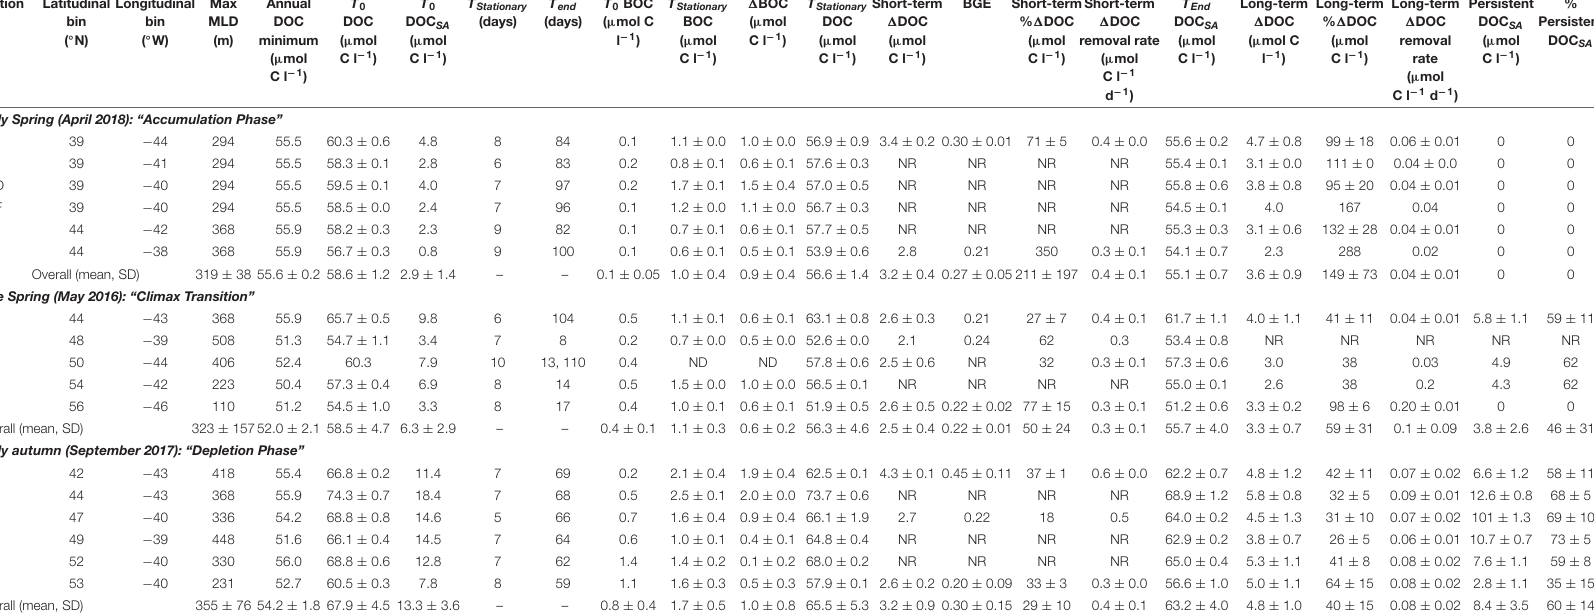
TABLE 1 | BGEs and DOC bioavailability from DOC remineralization experiments. Station Latitudinal